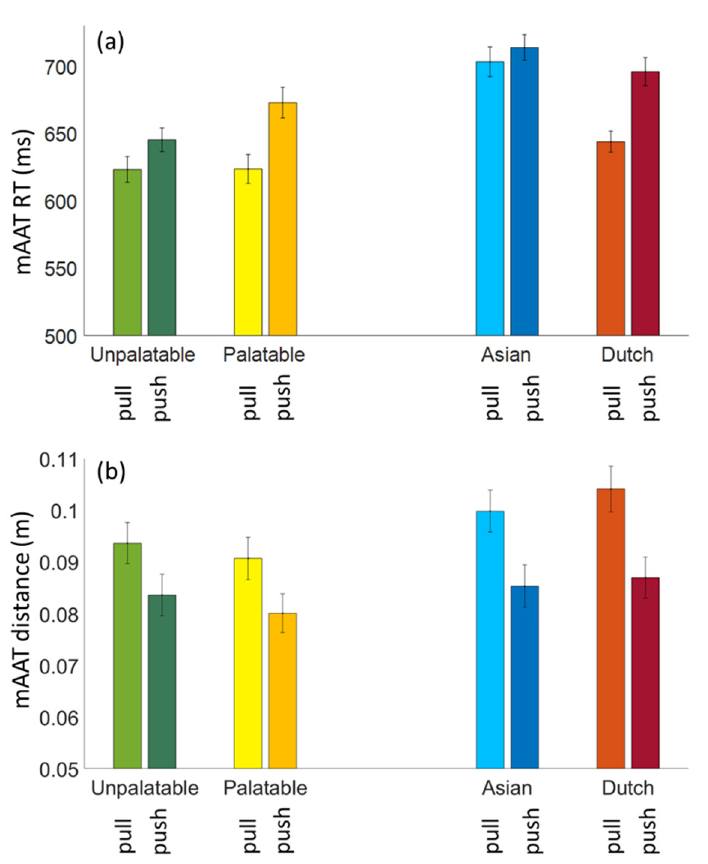
Figure 4. mAAT RT ( a ) and mAAT distance ( b ) for each of the four stimulus categories and each movement direction, pull and push.